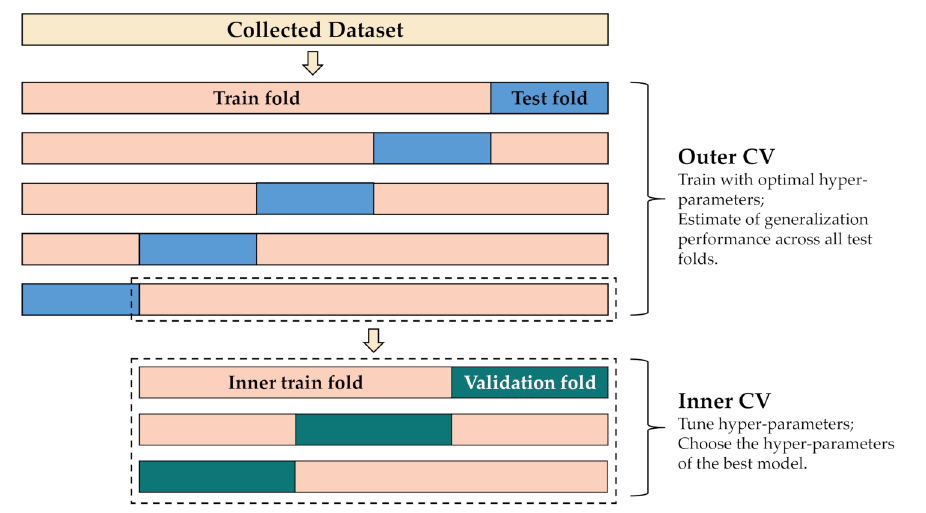
Figure 8. The flowchart of the fivefold nested